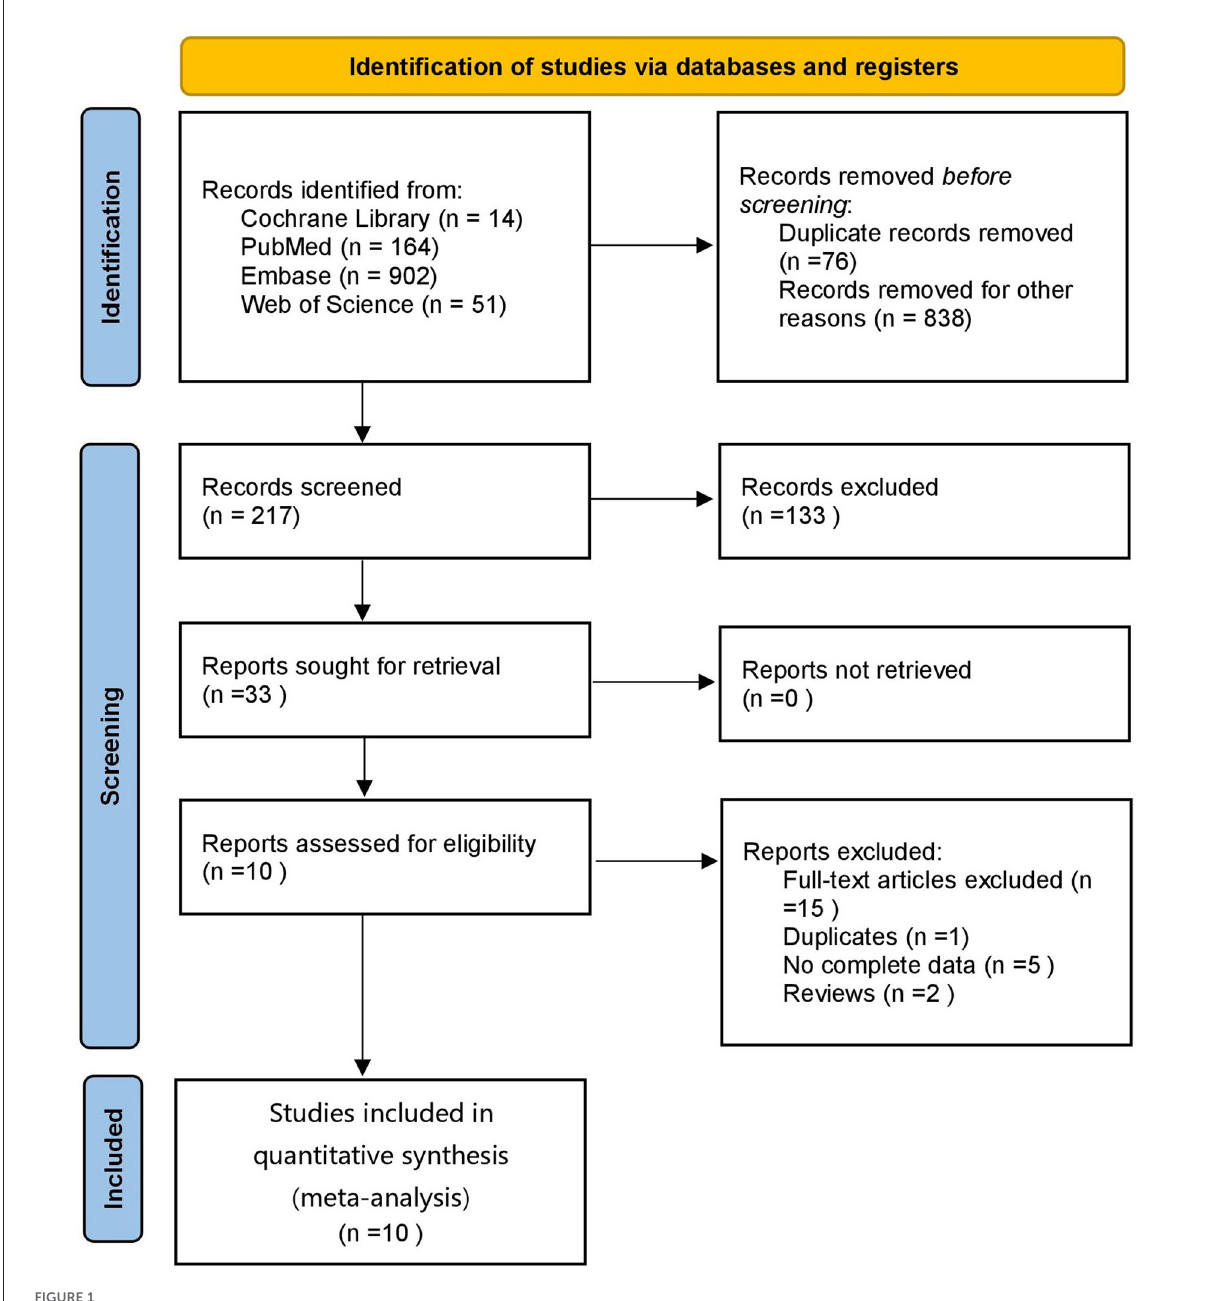
FIGURE1 Flow diagram of literature